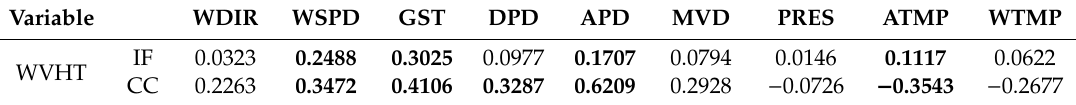
Figure 4. Importance ranking of predictors.